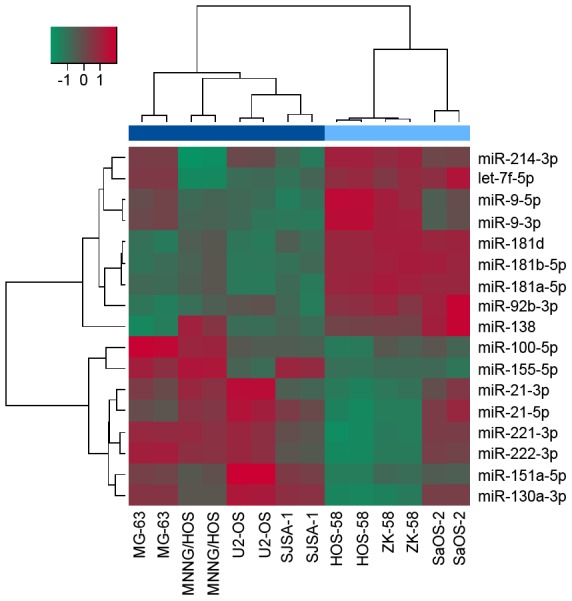
Clustering of differentially expressed microRNAs.The heatmap illustrates the expression profiles of DE microRNAs (log2 FC≥|1| & FDR<0.05, y-axis) among all OS cell samples (x-axis). High (dark blue) and low (light blue) proliferative OS samples are clearly separated. The red/green color code corresponds to the expression deviation from the average expression among all samples. Complete-linkage clustering was performed with the Pearson correlation as distance metric.